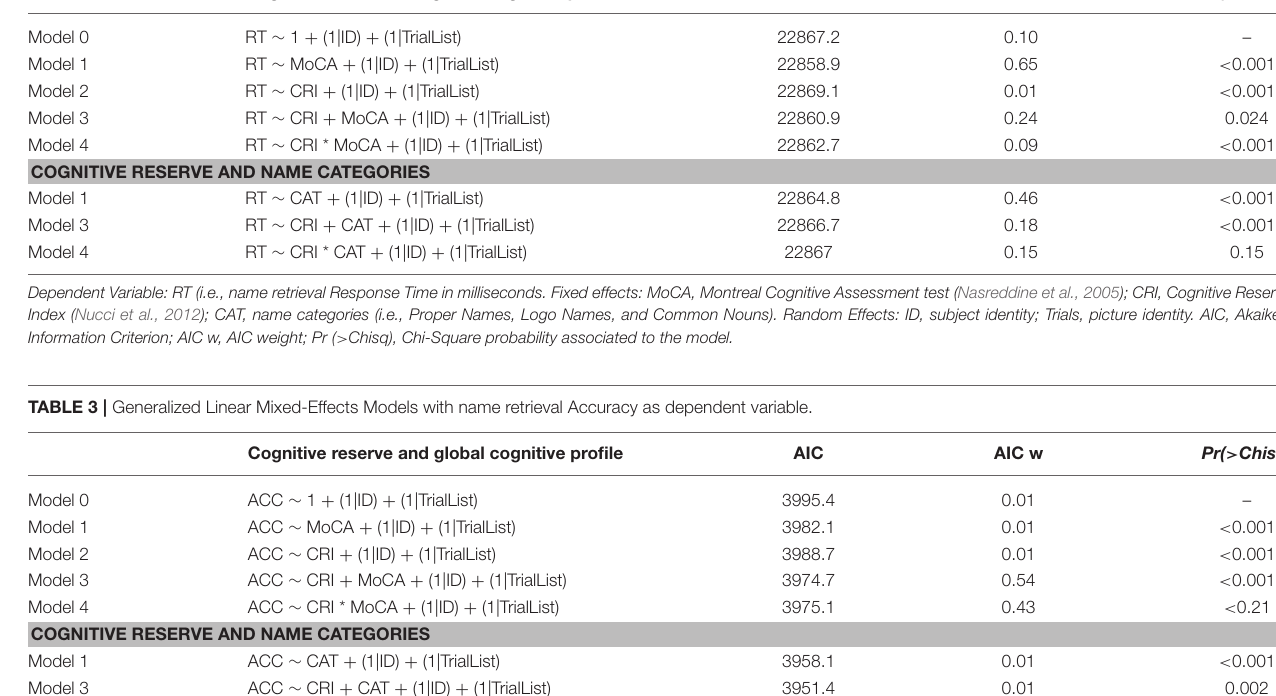
TABLE 2 | Generalized Linear Mixed-Effects Models with name retrieval Response Times as dependent variable. Cognitive reserve and global cognitive profile